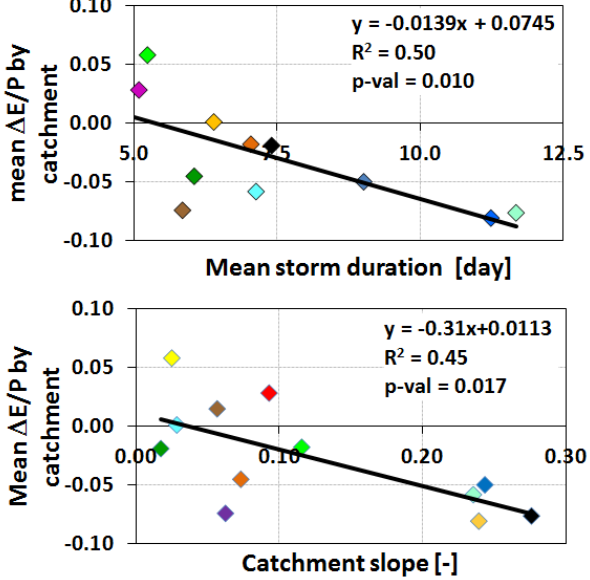
Figure 5 Fig. 5. Correlations between mean 1E/P by catchment and mean storm duration (top; sample size: 12; p value: 0.01) and average catchment slope (bottom; sample size: 12; p value: